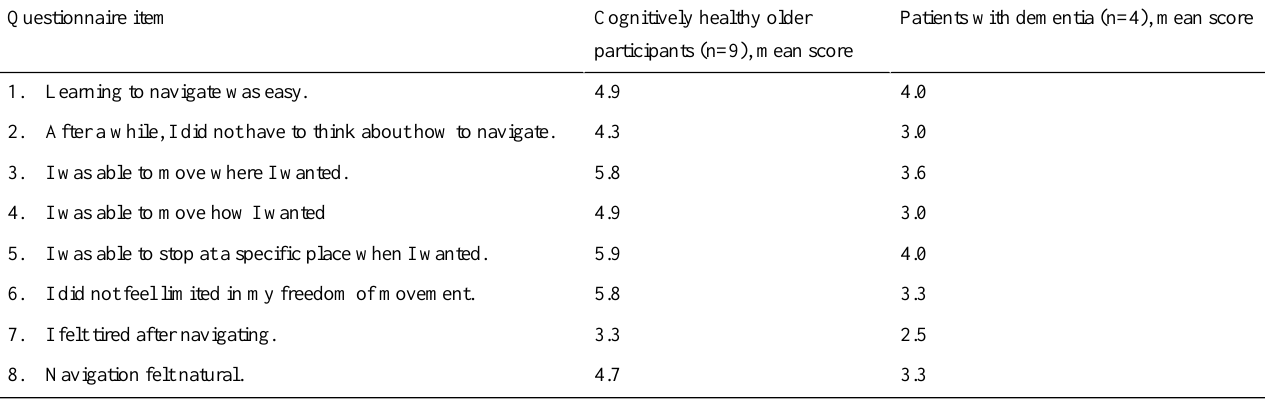
Table 3. Questionnaire regarding the usability of controlling movement in the virtual-reality environment for the cognitively healthy older participants (n=9; group mean score) and patients with dementia (n=4; group mean score). The scale ranged from 1 (fully disagree) to 7 (fully agree). Patients with dementia (n=4), mean scoreCognitively healthy older participants (n=9), mean